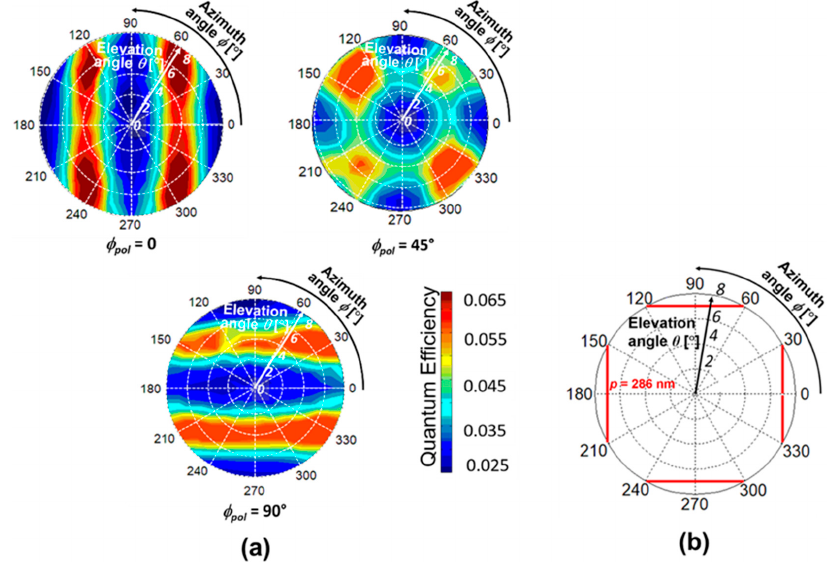
Figure 9. ( a ) Measured spatial patterns in SOI PD with a 2D hole array SP antenna for different polarizations of (i) φ pol = 0, 45 ° , and 90 ° ; ( b ) theoretical spatial pattern of a peak incident angle based on phase matching conditions to verify the measurements reproduced from [22]. The grating period is fixed at p = 286 nm.